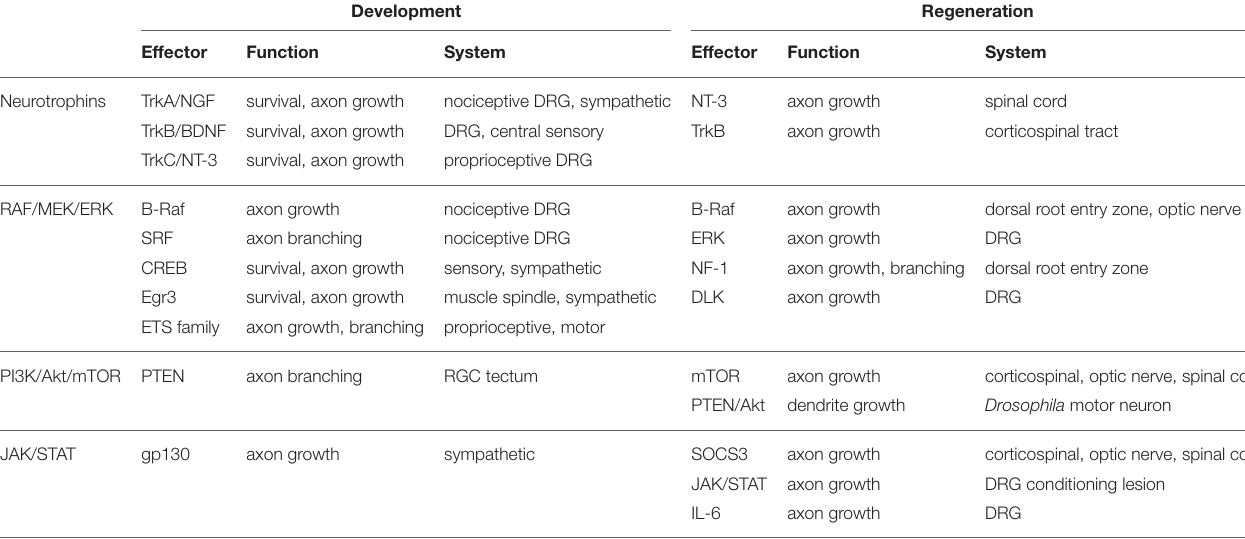
TABLE 1 | Partial summary of how the neurotrophins, RAF/MEK/ERK, PI3K/Akt/mTOR, and JAK/STAT pathways are involved in development and